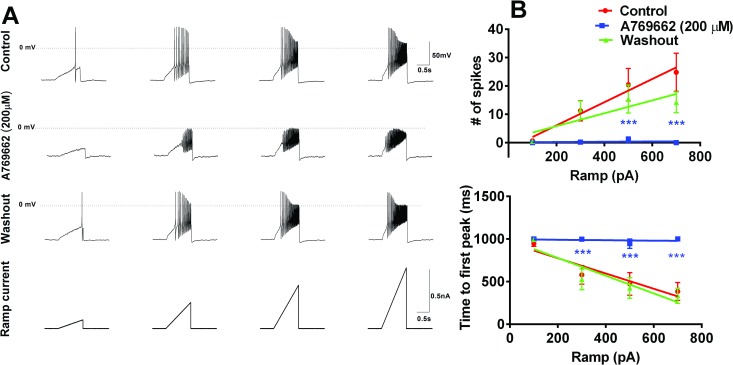
A769662 applied acutely to rat TG neurons blocks AP firing evoked by ramp current stimuli.(A) Representative action potential traces in response to ramp current stimuli before and after acute application of (5 sec) of A769662 (200 μM). Acute application of A769662 (n = 5) onto rat TG neurons significantly reduced numbers of action potentials (B) and reversed time-to-first action potential (AP) peak compared to control (n = 5). This effect was reversible with washout (n = 5). Differences in the mean numbers of action potentials among groups were analyzed by comparing the slopes and intercepts generated from linear regression Comparisons among groups for time to first spike were performed by two-way ANOVA. Colored stars denote significant effects compared to control group. * p < 0.05, ** p < 0.01 and *** p < 0.001.